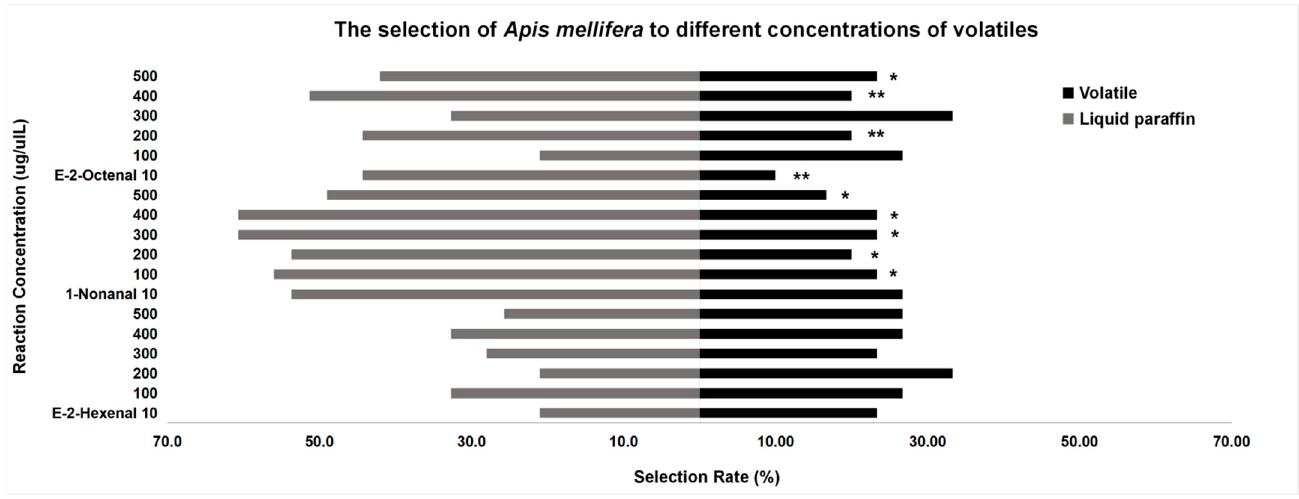
Figure 4. Comparison of EAG responses between A. mellifera and B. terrestris to 3-phenlyl-2-propenal, 2,5-dimethyl-benzaldehyde, and dodecanal. “*”means significant difference ( p < 0.05).